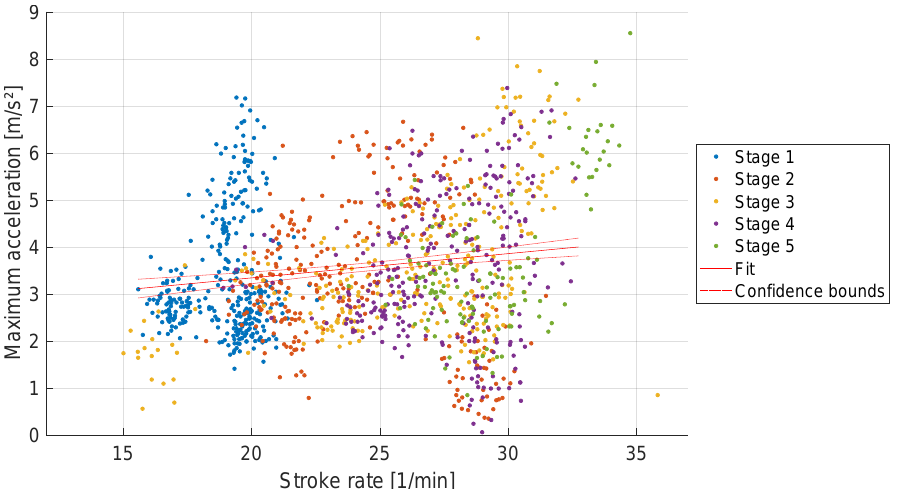
Figure 5. Maximum acceleration over stroke rate during five stage rowing training. A linear regres- sion fit, and 95% confidence interval is marked in